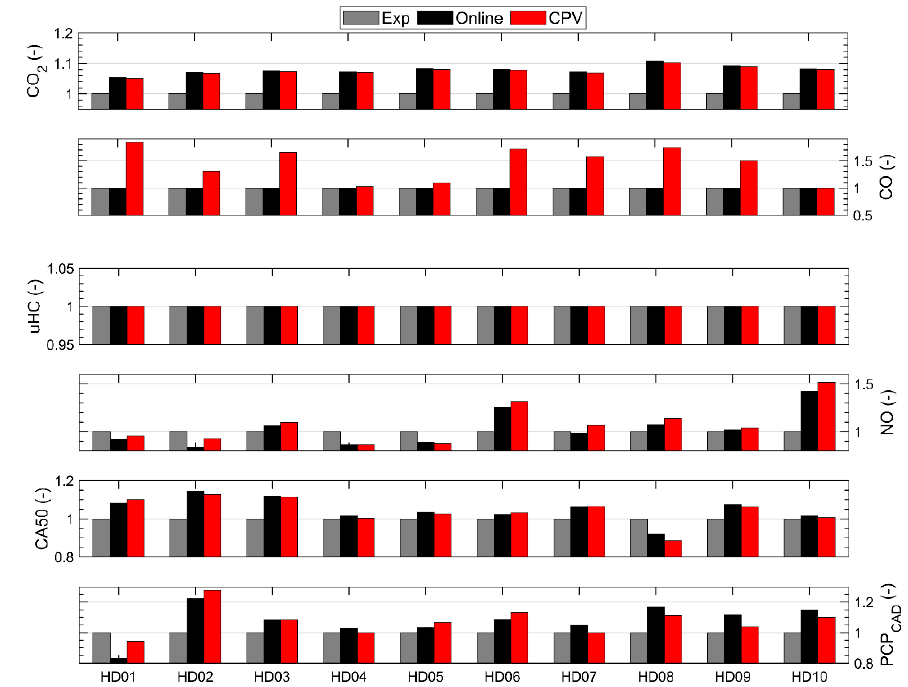
Figure 8. Experimental and simulated engine-out emissions as well as performance parameters (CA50 and PCP CAD location) for all operating conditions of the heavy-duty engine simulation campaign. Data have been normalized with respect to experimental values.